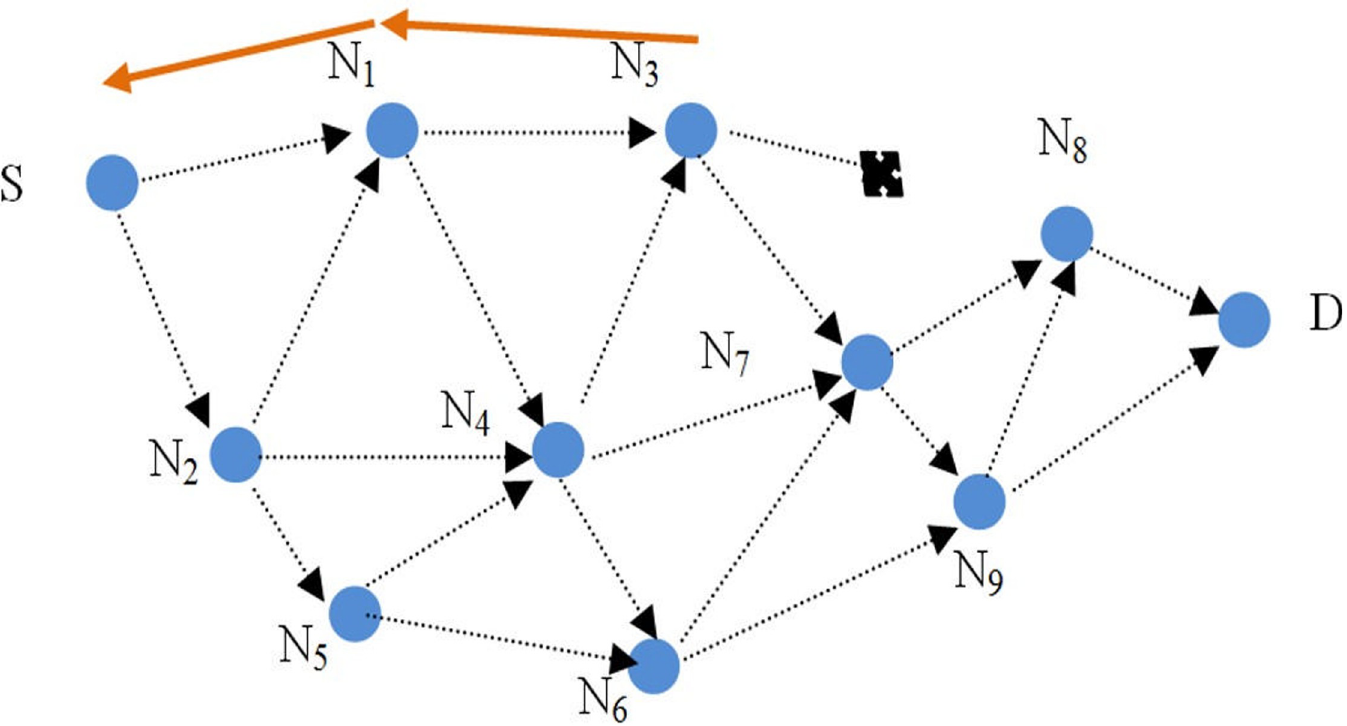
Fig 4. The intermediate nodes break the route, sending the route error packet.